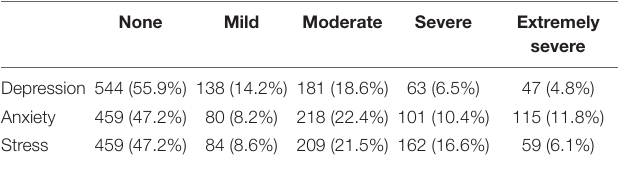
TABLE 1 | Frequencies and percentages of the perceived level of depression, anxiety and stress symptoms (none, mild, moderate, severe, and extremely severe) suffered by health